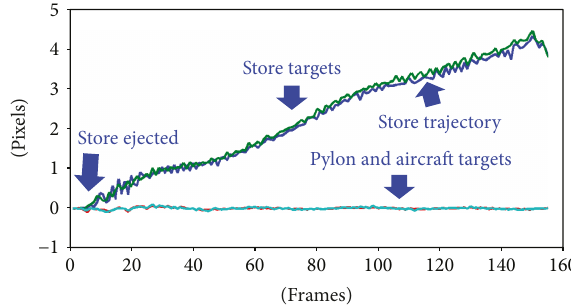
Figure 24: Indication of the start of store separation.